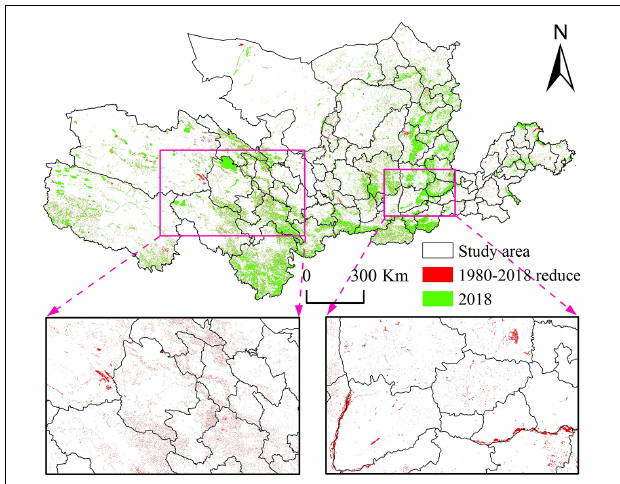
FIGURE 5 | Spatial change in ecological security land, 1980–2018.